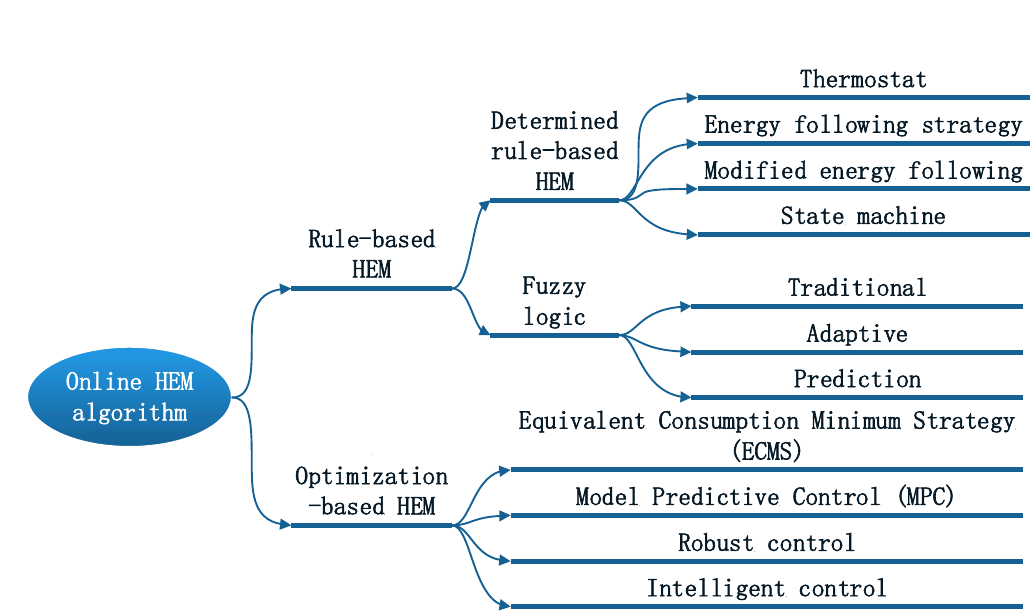
Figure 4. Online classification of energy management algorithms.